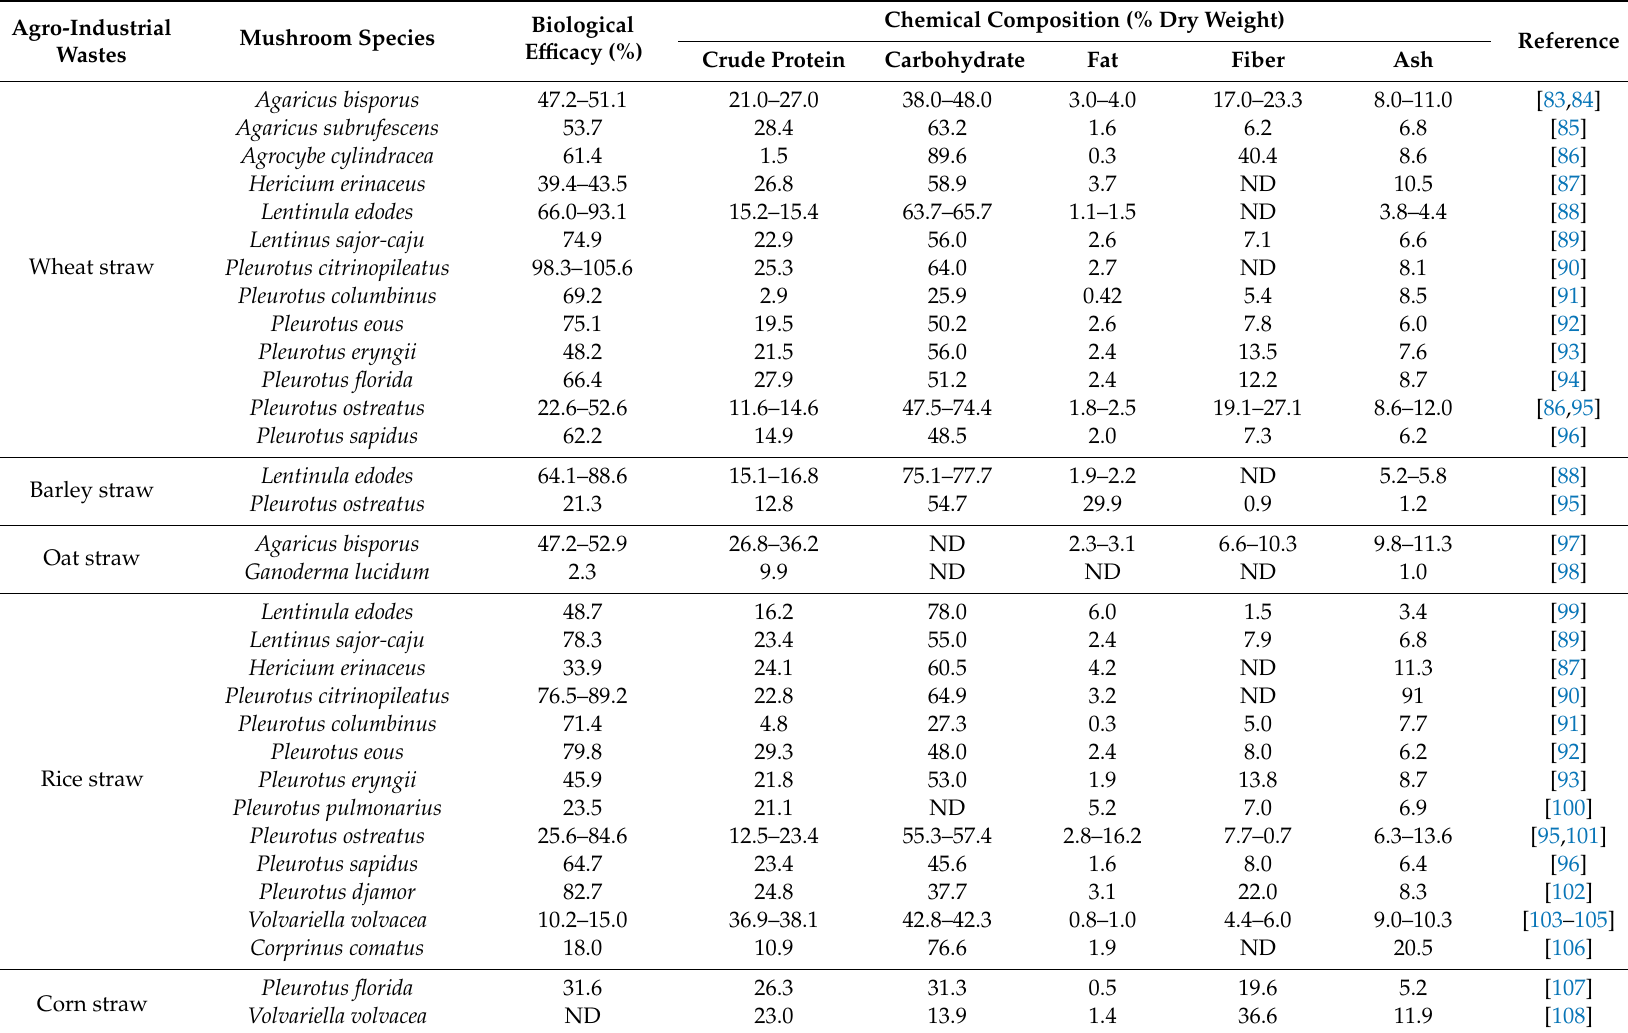
Table 3. Biological e ffi ciency and chemical composition of some mushrooms grown on the non-combination of agro-industrial wastes.